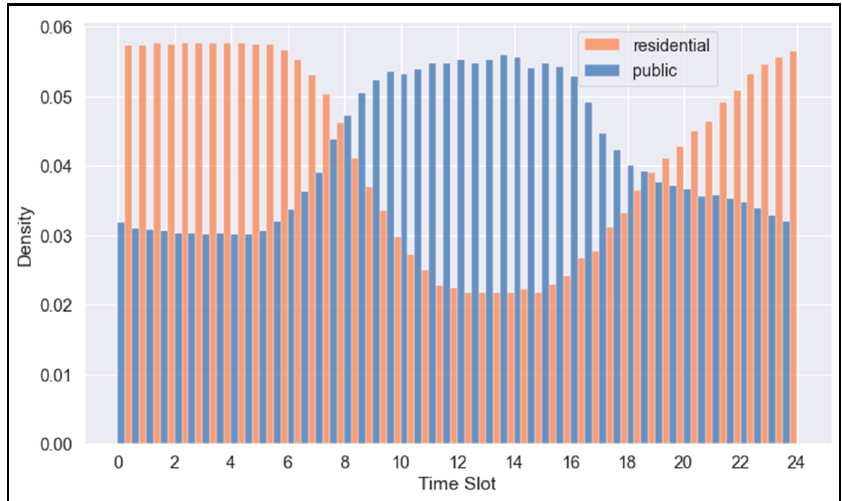
Figure 3. Distribution of public and residential charging station occupation over 30-min time slots.